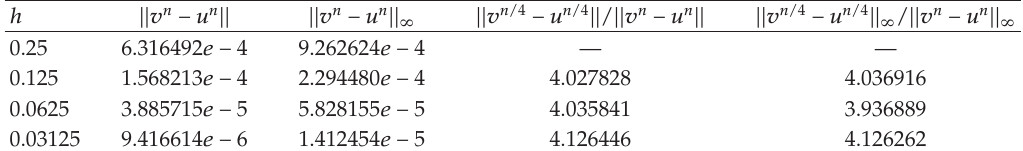
with an initial condition